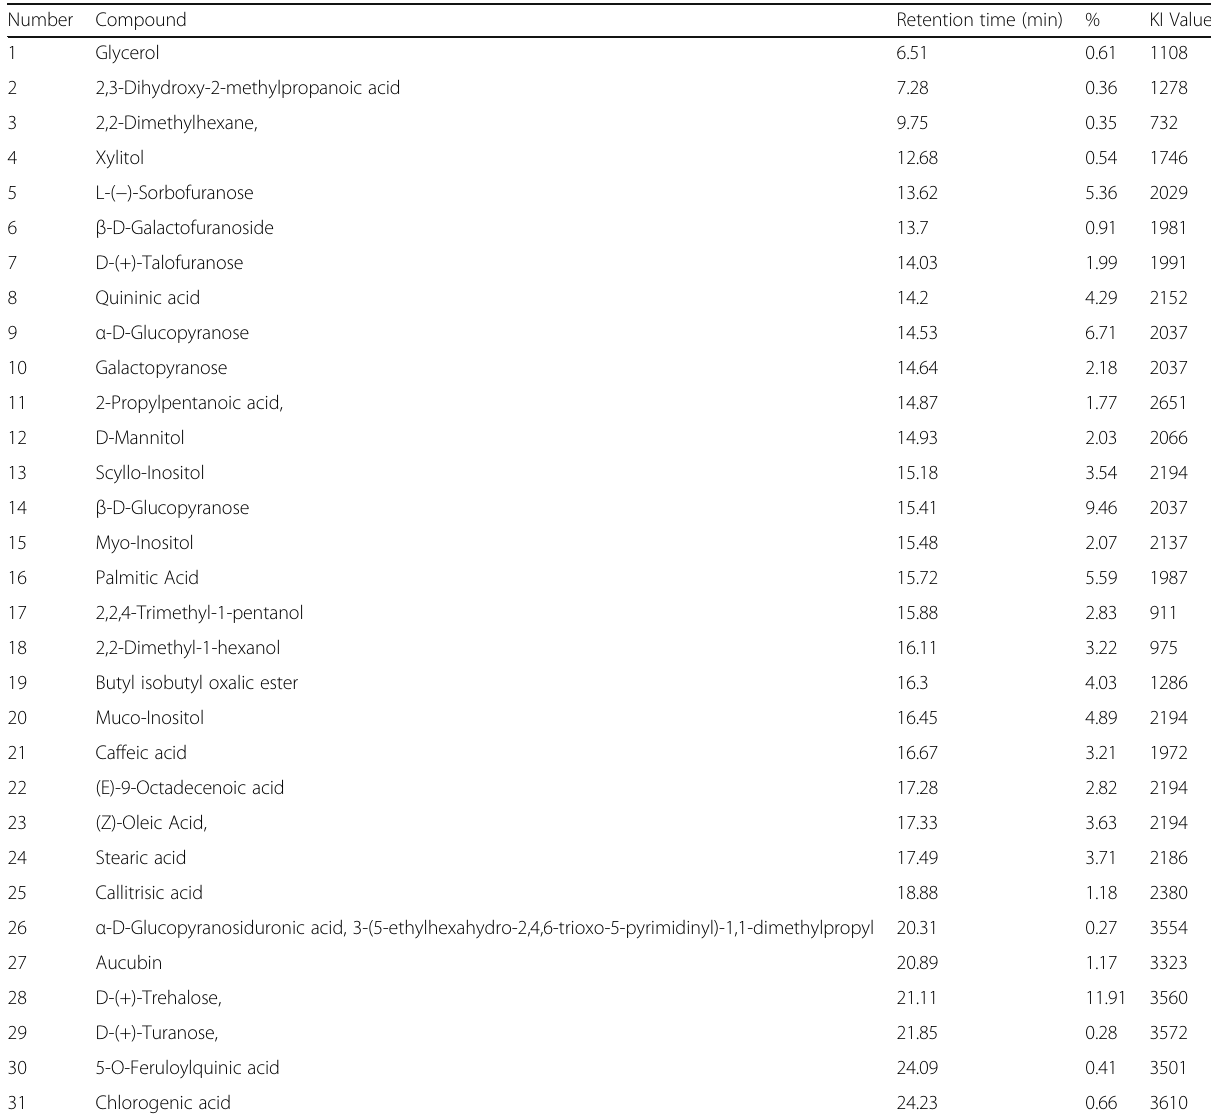
Table 1 GC-MS Analysis of the Composition of MEJG Number Compound